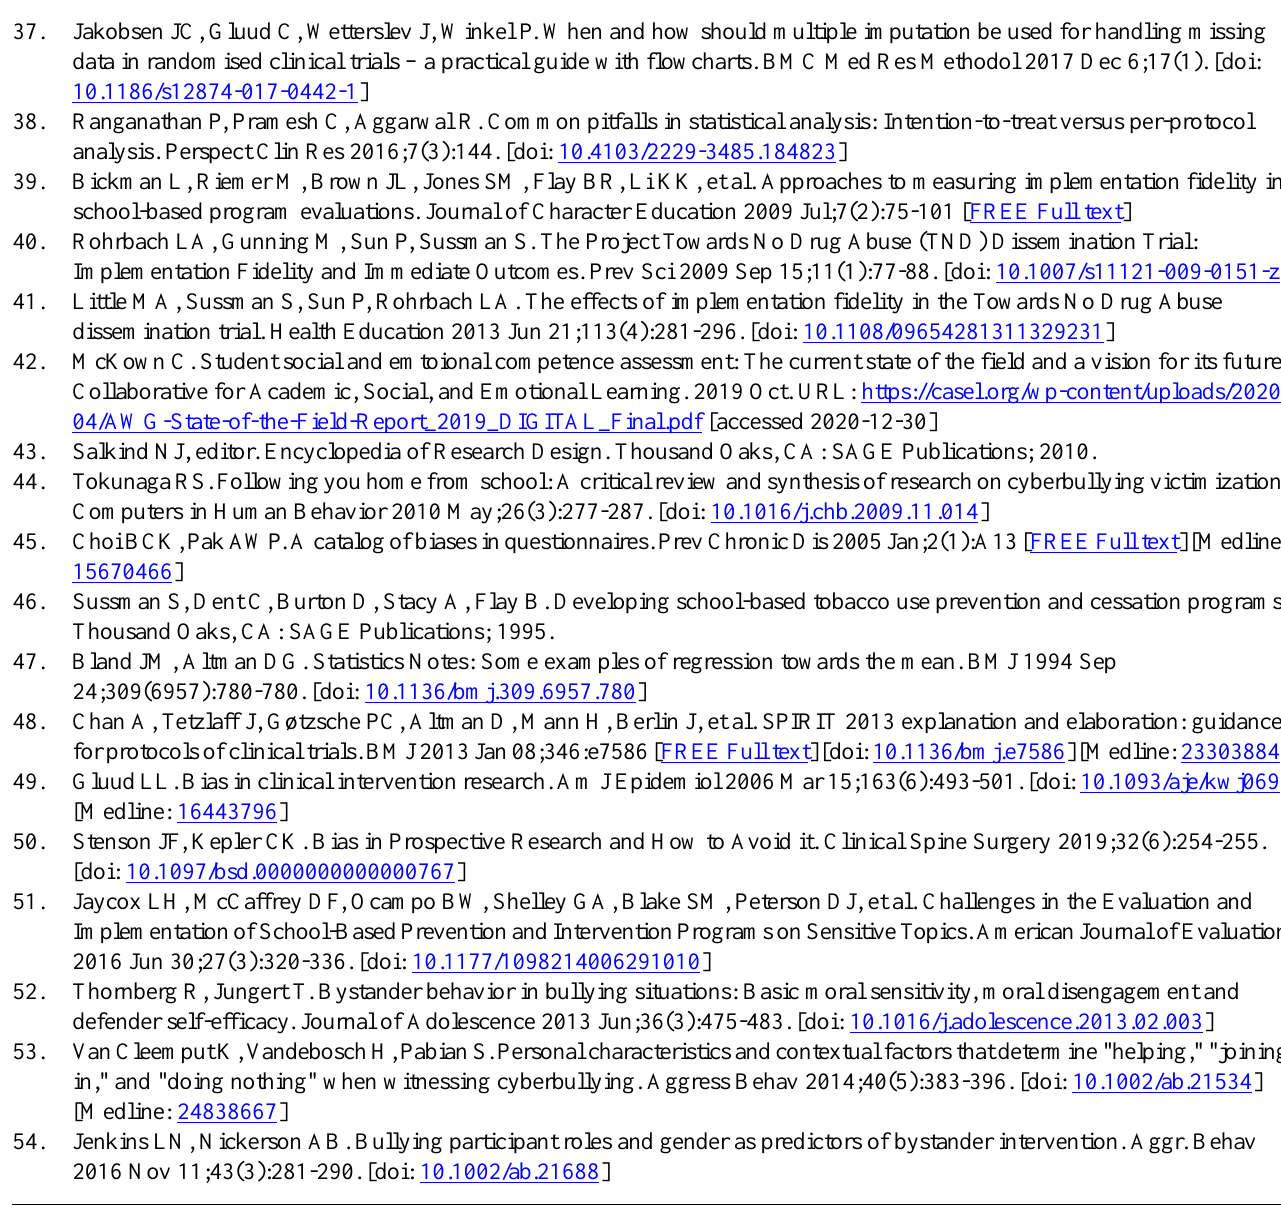
Abbreviations BCS-A: Bullying and Cyberbullying Scale for